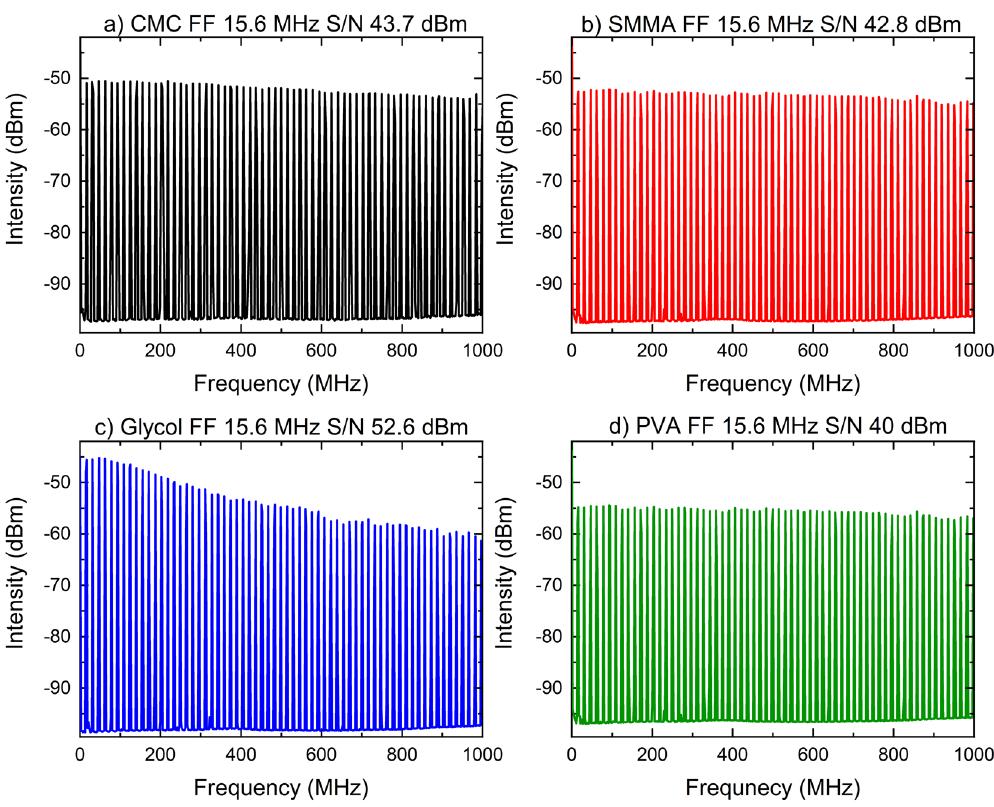
Figure 4. Radio frequency spectrums of the laser with ( a ) CMC, ( b ) SMMA, ( c ) Glycol and ( d ) PVA. The Fundamental Frequency (FF) was 15.6 MHz. Moreover, signal to noise ratio (S/N) were above 40 dBm.